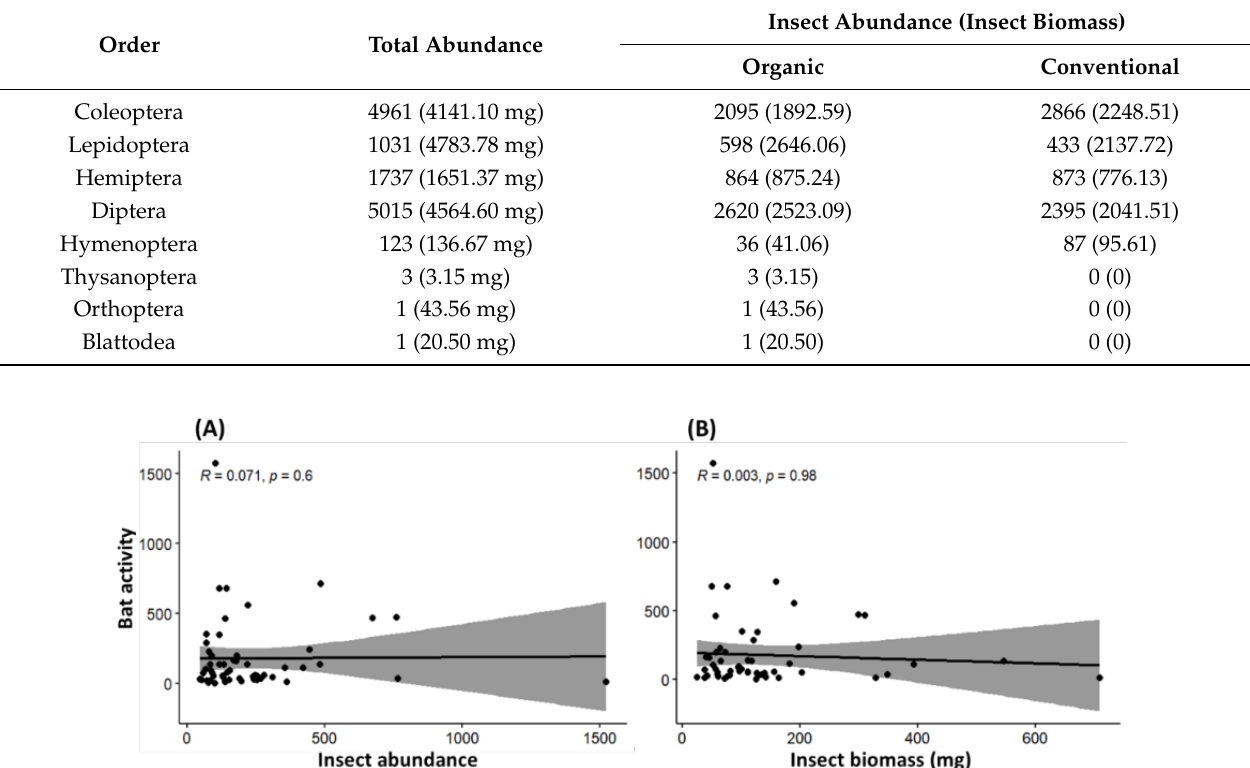
Figure 3. Correlations between total bat activity (number of bat passes) with insect abundance ( A ) and insect biomass ( B ). Each plotted point represents data from a single survey event at a given sampling location.